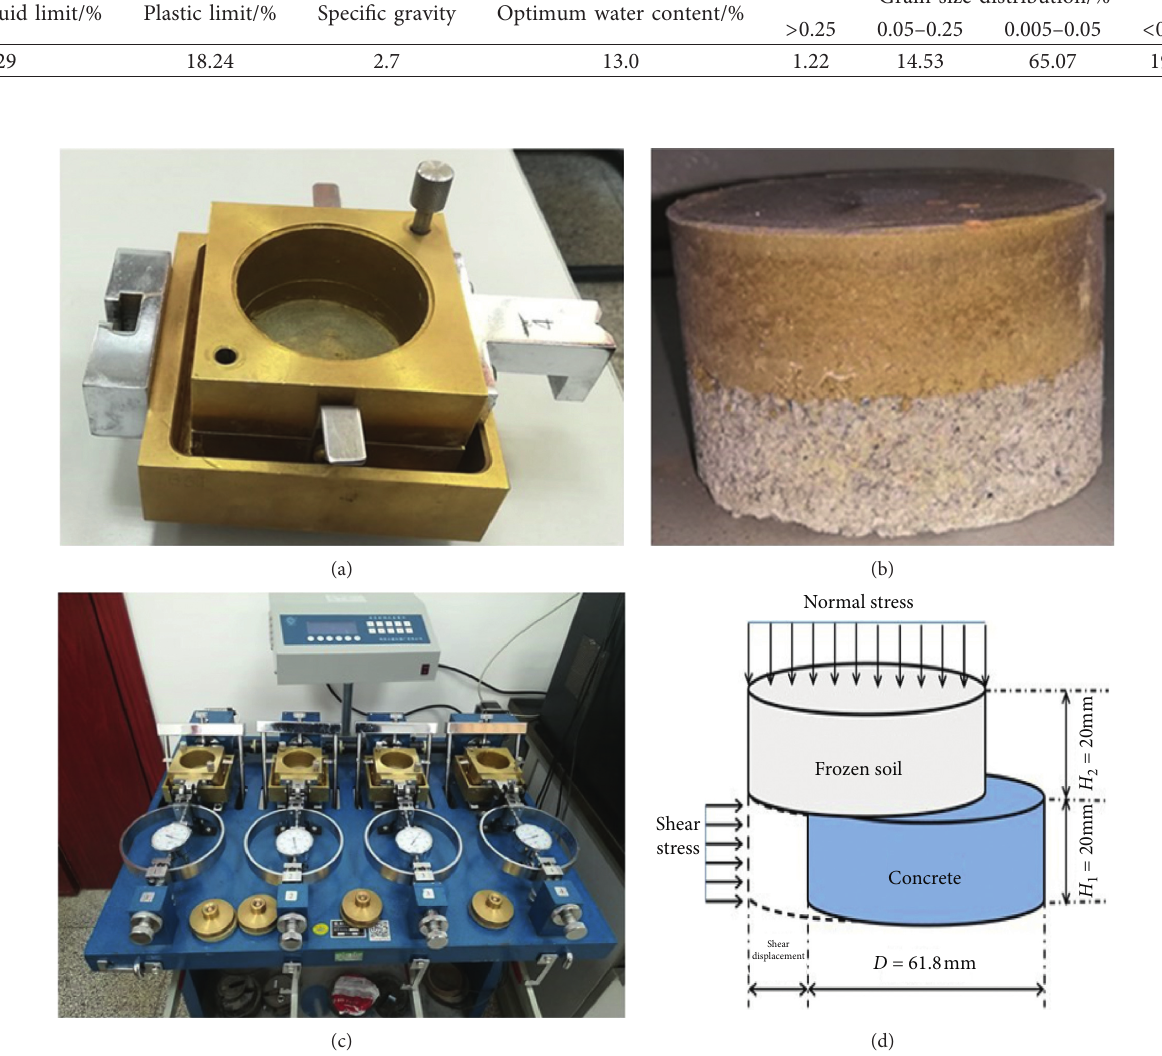
Figure 1: Test apparatus (a, c), the concrete-soil specimen (b), and stress state of the specimen during shearing (d).